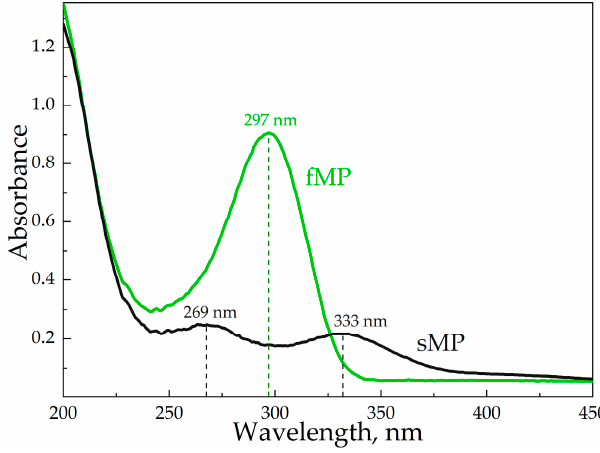
Figure 6. UV-spectra of freshly prepared MP solution (fMP) and the solution, stored for 2 months (sMP), C MP = 0.1 mM.